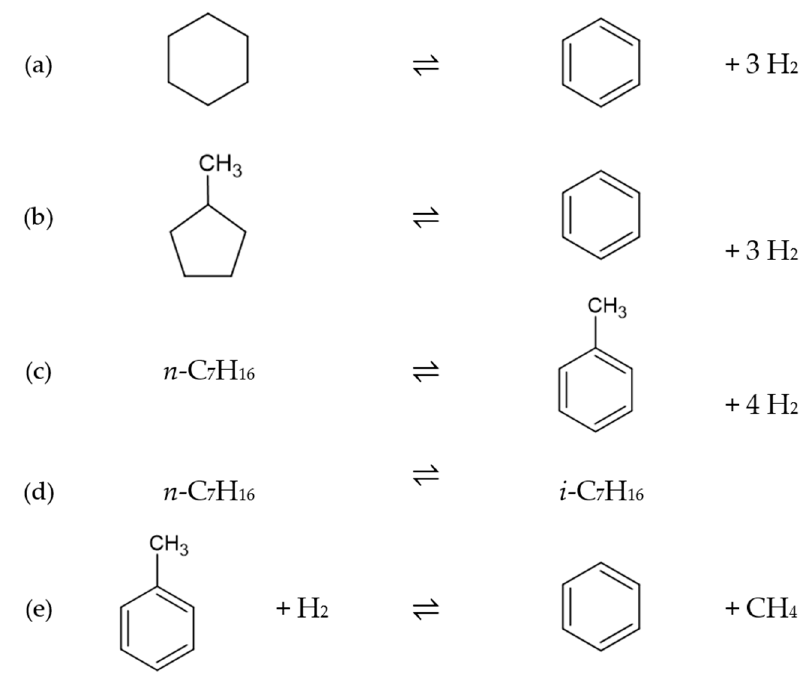
Figure 1. Catalytic reforming reactions. ( a ) Naphtenes dehydrogenation to aromatics, ( b ) alkyl cyclopentanes dehydroisomerization to aromatics, ( c ) alkanes dehydrocyclization to aromatics, ( d ) n- alkanes isomerization to branched alkanes, and ( e ) cracking reactions to lower carbon products.